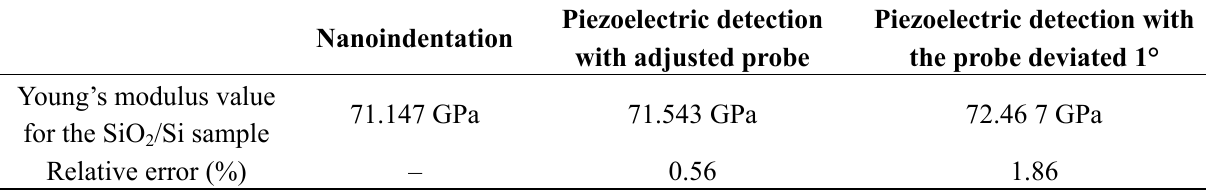
Table 2. The comparison between the results of the nanoindentation and the four-quadrant piezoelectric detection